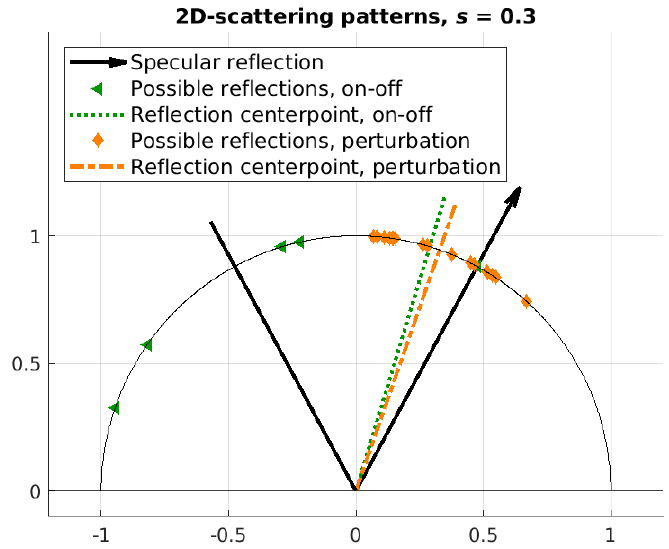
Figure 1. 2D view of some possible reflected rays in the on–off and perturbation scattering algorithms. Center points for the aggregate reflected energy are shown for both algorithms. Approximately 70% of the rays reflected using the on-off algorithm will be reflected in the specular